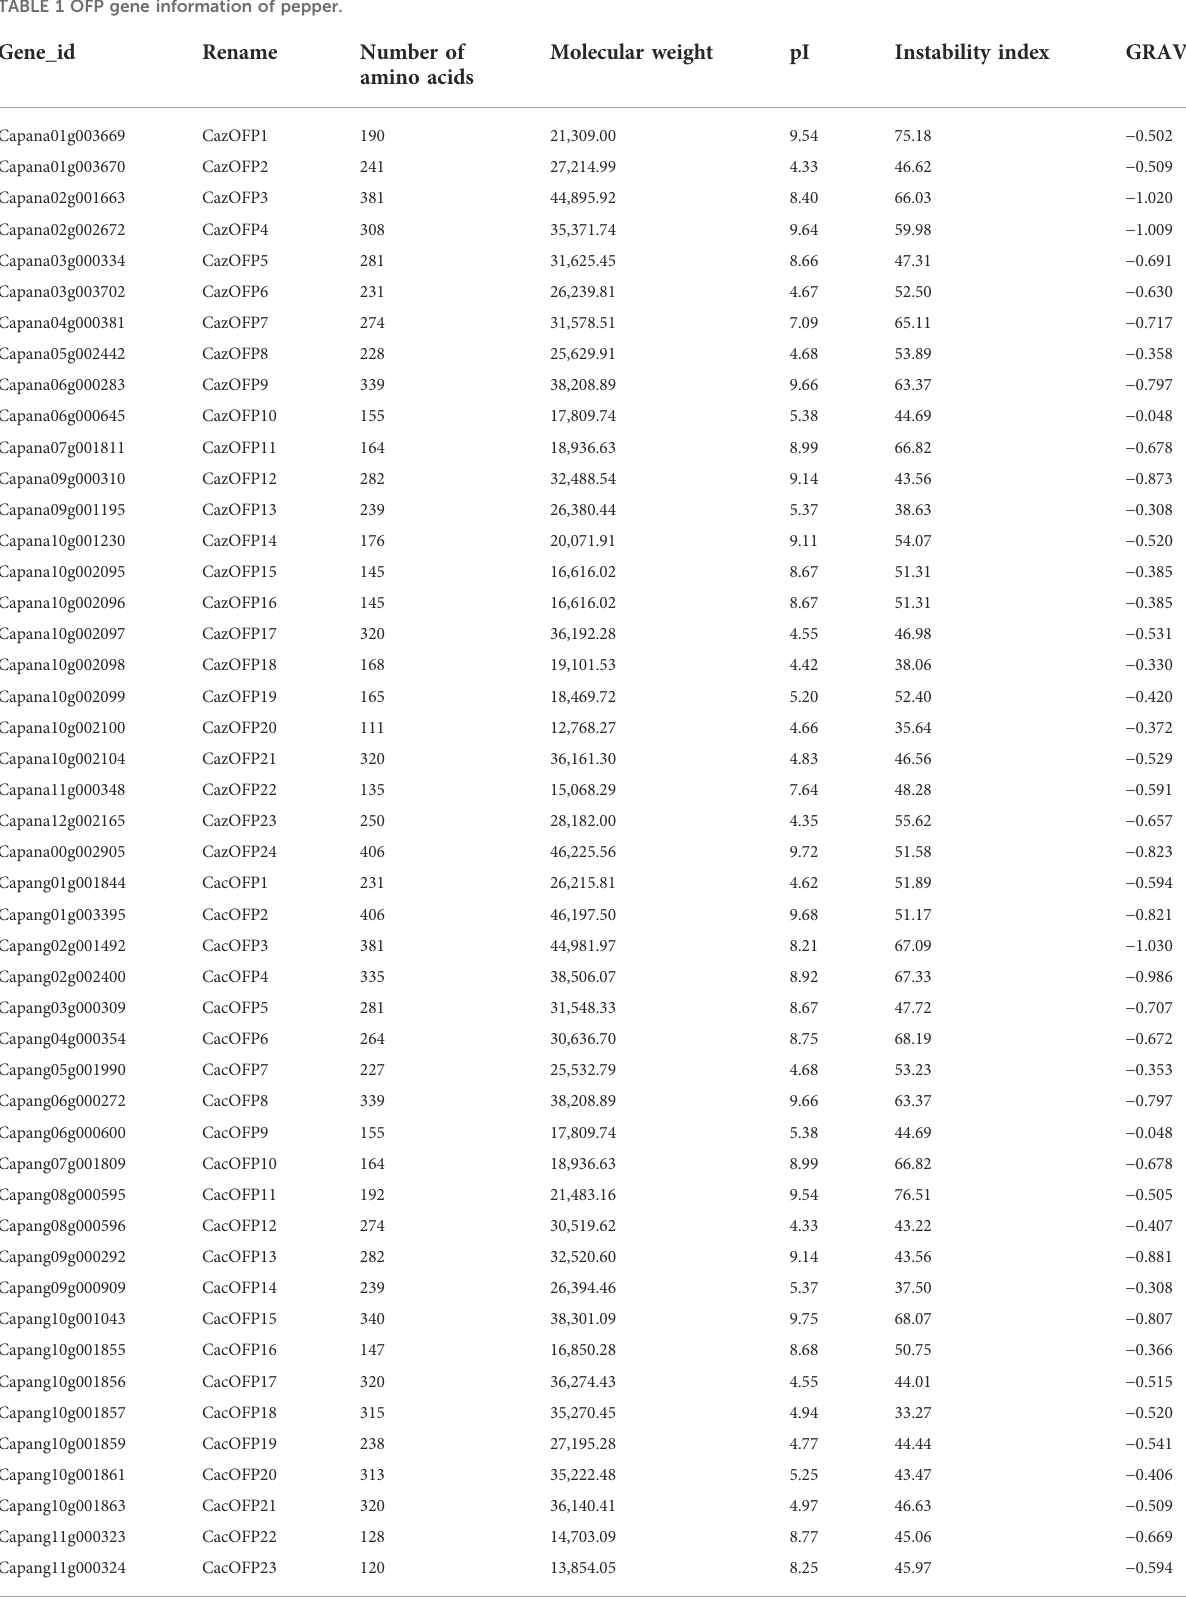
TABLE 1 OFP gene information of